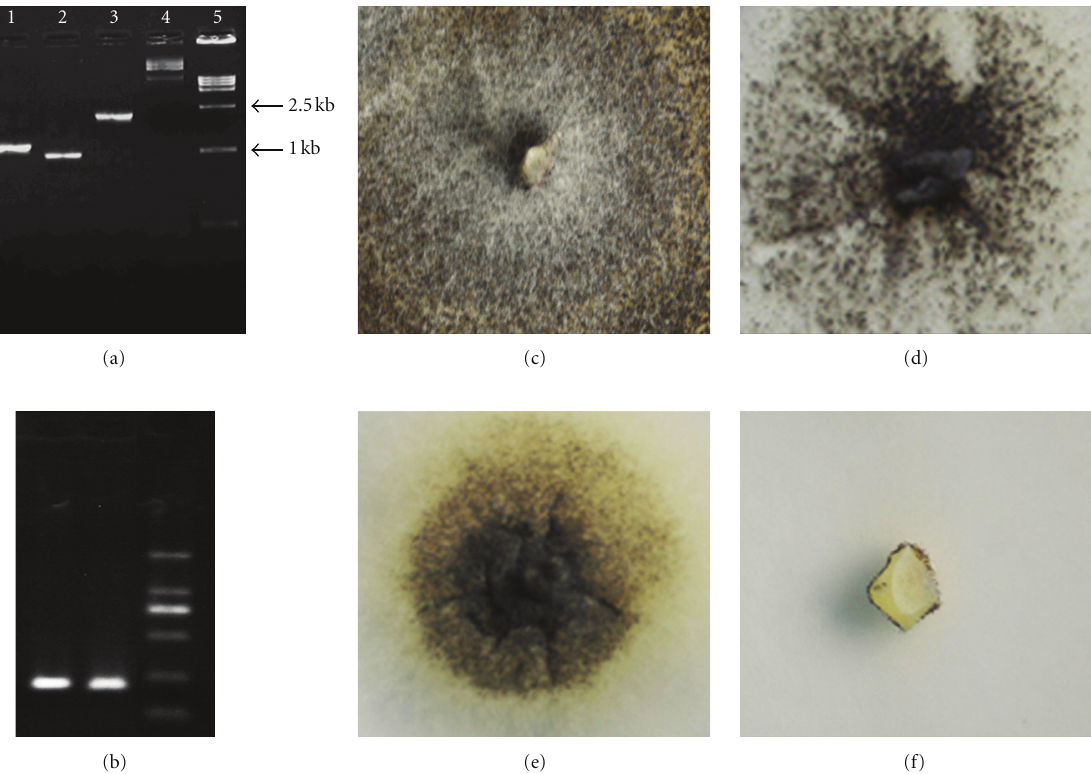
Figure 2: PCR verification of the vfFAD2-FDMV2A-vfDGAT2 /pCAMBIA1301 recombinant vectors and A. fumigatus / vfFAD2-FDMV2A- vfDGAT2 transformant. (a) PCR verification of the vfFAD2-FDMV2A-vfDGAT2 /pCAMBIA1301 recombinant vector. (b) PCR amplification of the A. fumigatus transformant using special primers. (c–f) A. fumigatus transformants grew in PDA medium containing 100 µ g/mL hygromycin B. 1, vfDGAT2; 2: vfFAD2; 3: vfFAD2-FMDV2A-vfDGAT2 ; 4: pCAMBIA1301 vector; 5: DNA Marker. (c) A . fumigatus / vfFAD2- FDMV2A-vfDGAT2 ; (d) A. fumigatus / vfFAD2 : (e) A. fumigatus / vfDGAT2 ; (f) A. fumigatus .